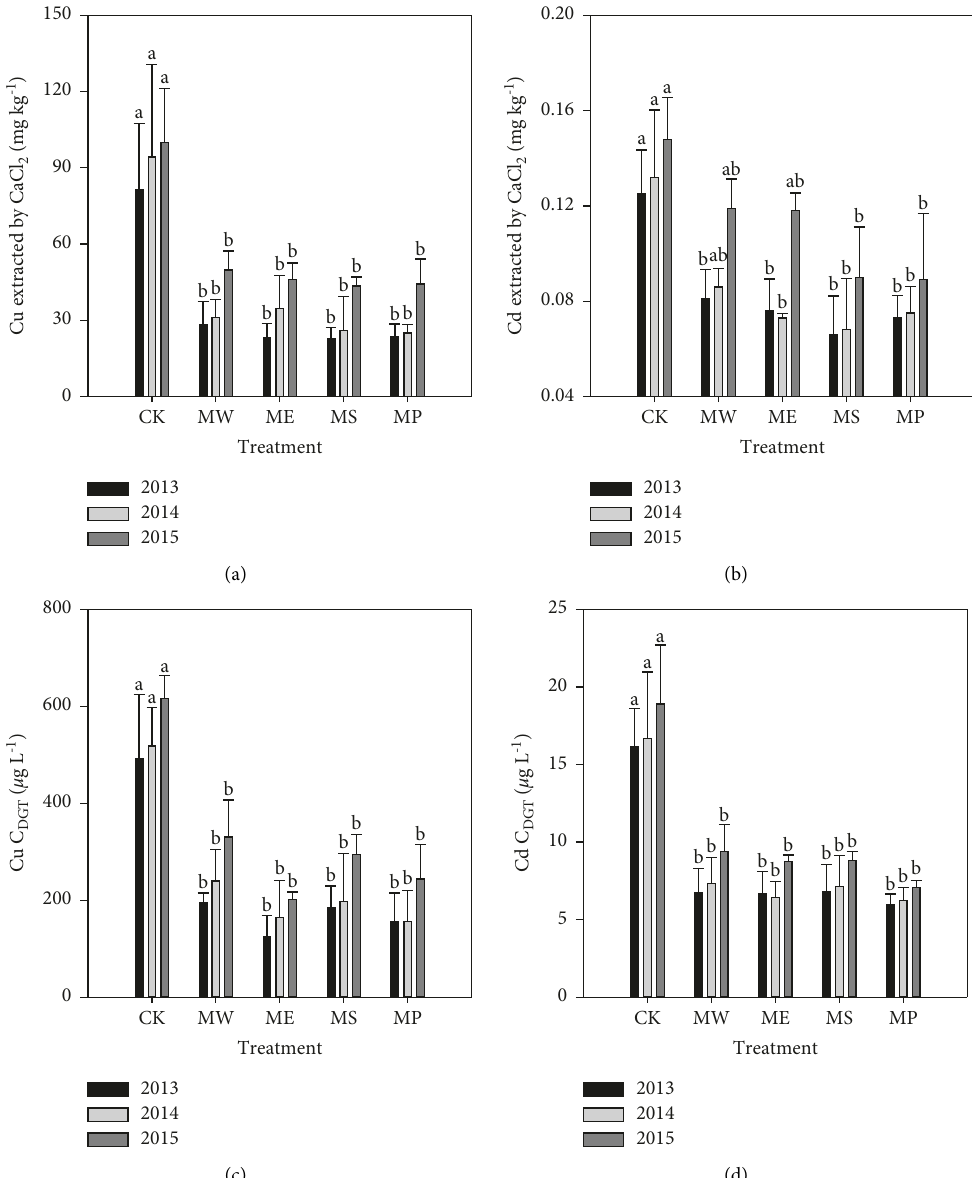
Figure 2: CaCl 2 -extractable Cu and Cd and CDGT Cu and Cd in soils during 3 years. MW MS � Sedum plumbizincicola, and MP � Pennisetum sp. Different lowercase letters indicate significant differences in the same treatment during the three years ( n � 3, P < 0 .